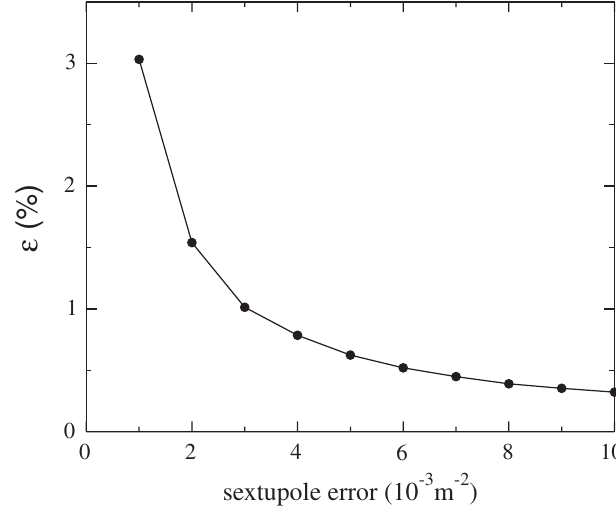
FIG. 7. The action and phase jump method determines sextu- pole errors within a 3% uncertainty in the range of strengths of interest for RHIC